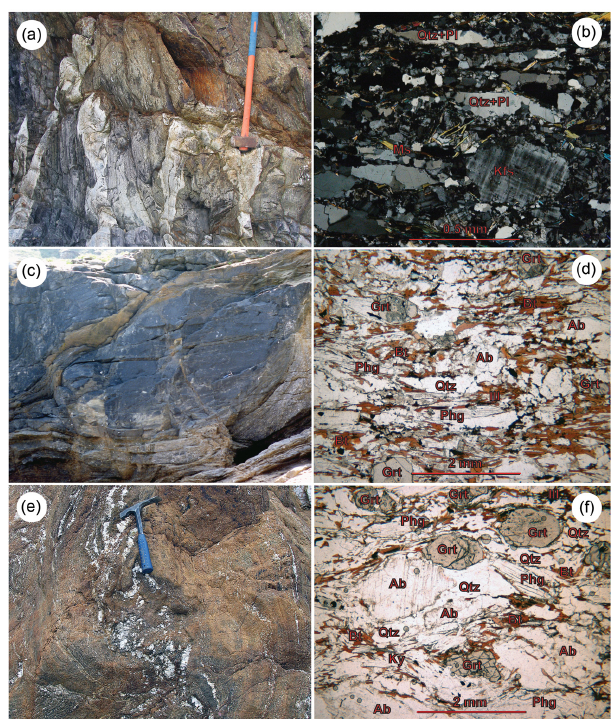
Figure 4. Migmatitic biotite qz-fsp gneisses and related rocks. (a) Folding affecting a felsic dioritic dyke and the S 2 foliation. (b) Microphotograph of the felsic diorite dyke showing a coarse foliation (sample DM-2). (c) Anastomosing shear zones defined by the S 2 foliation surrounding lozenges of less deformed migmatitic qz-fsp gneisses. (d) Microphotograph of the biotite qz-fsp gneisses (sample B23). (e) Restite in migmatitic qz-fsp gneisses. (f) Mi- crophotograph of the leucocratic qz-fsp gneisses (sample B12). Sample locations are in Fig. 2a.